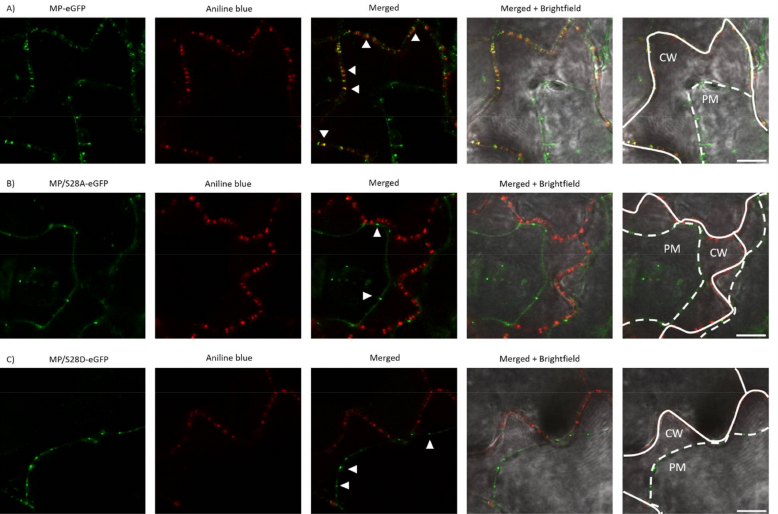
Figure 6. Subcellular localization of wild type and mutant MP-eGFP constructs in aniline blue stained Nicotiana tabacum cv. Xanthi leaves. ( A – C ) Images were taken 24–48 h after agroinfiltration with a confocal microscope. For plasmolysis treatment, leaves were soaked in 10% NaCl solution immediately before examination. For better visualization, eGFP fluorescent and aniline blue images were false colored as green and red, respectively. The plasma membrane (PM) and the cell wall (CW) were marked by white dashed and continuous lines, respectively. Arrowheads indicate the punctate structures. Scale bar: 10 µ